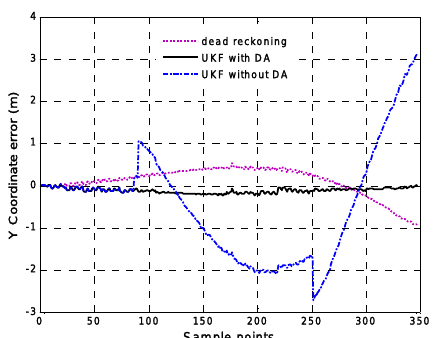
Fig. 9. Localization Y Coordinate Fig.8 and Fig.9 show the large localization errors by utilizing the UKF without data association method. There are two steep position change. When the magnetic ruler detects the fault marker, which is not belong to the position reference marker, the large steep position errors are produced due to the incorrect position mesurement reference from the fault marker.